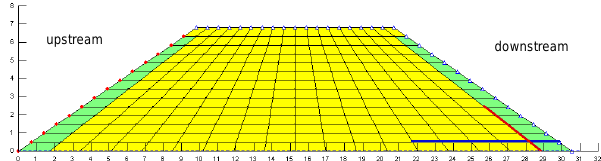
Figure 10 - Saturation levels in the embankment at different times in the hypothesis of low 5 permeability soil strata along the two embankment slopes. 6 Fig. 10. Saturation level in the embankment at different times in the hypothesis of low permeability soil strata along the two embank- ment slopes.